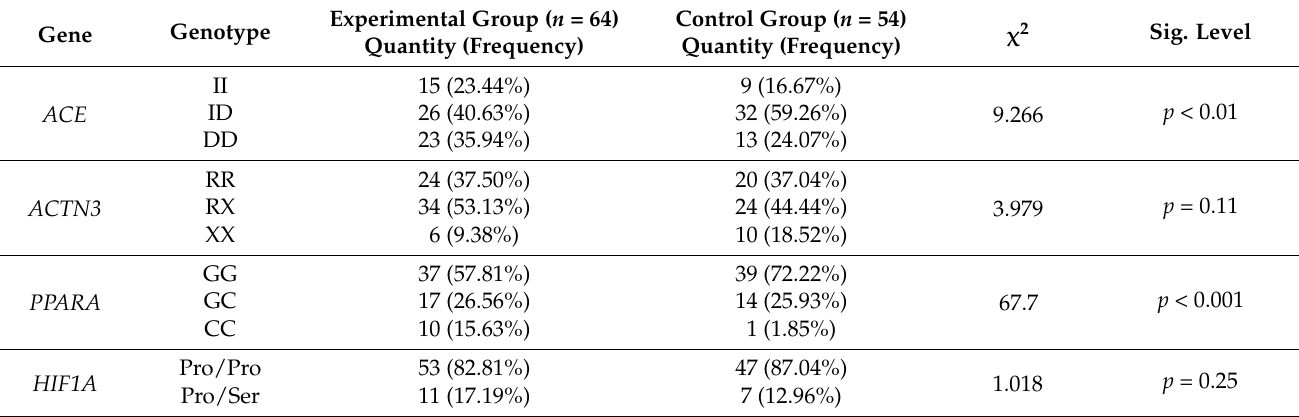
Table 1. Frequency of genotypes and their comparison between experimental and control groups.